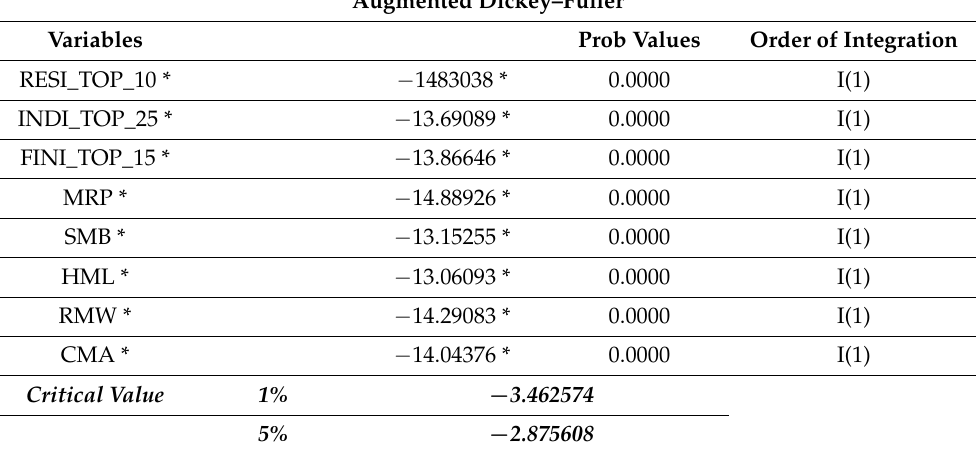
Table 2. Stationarity Test